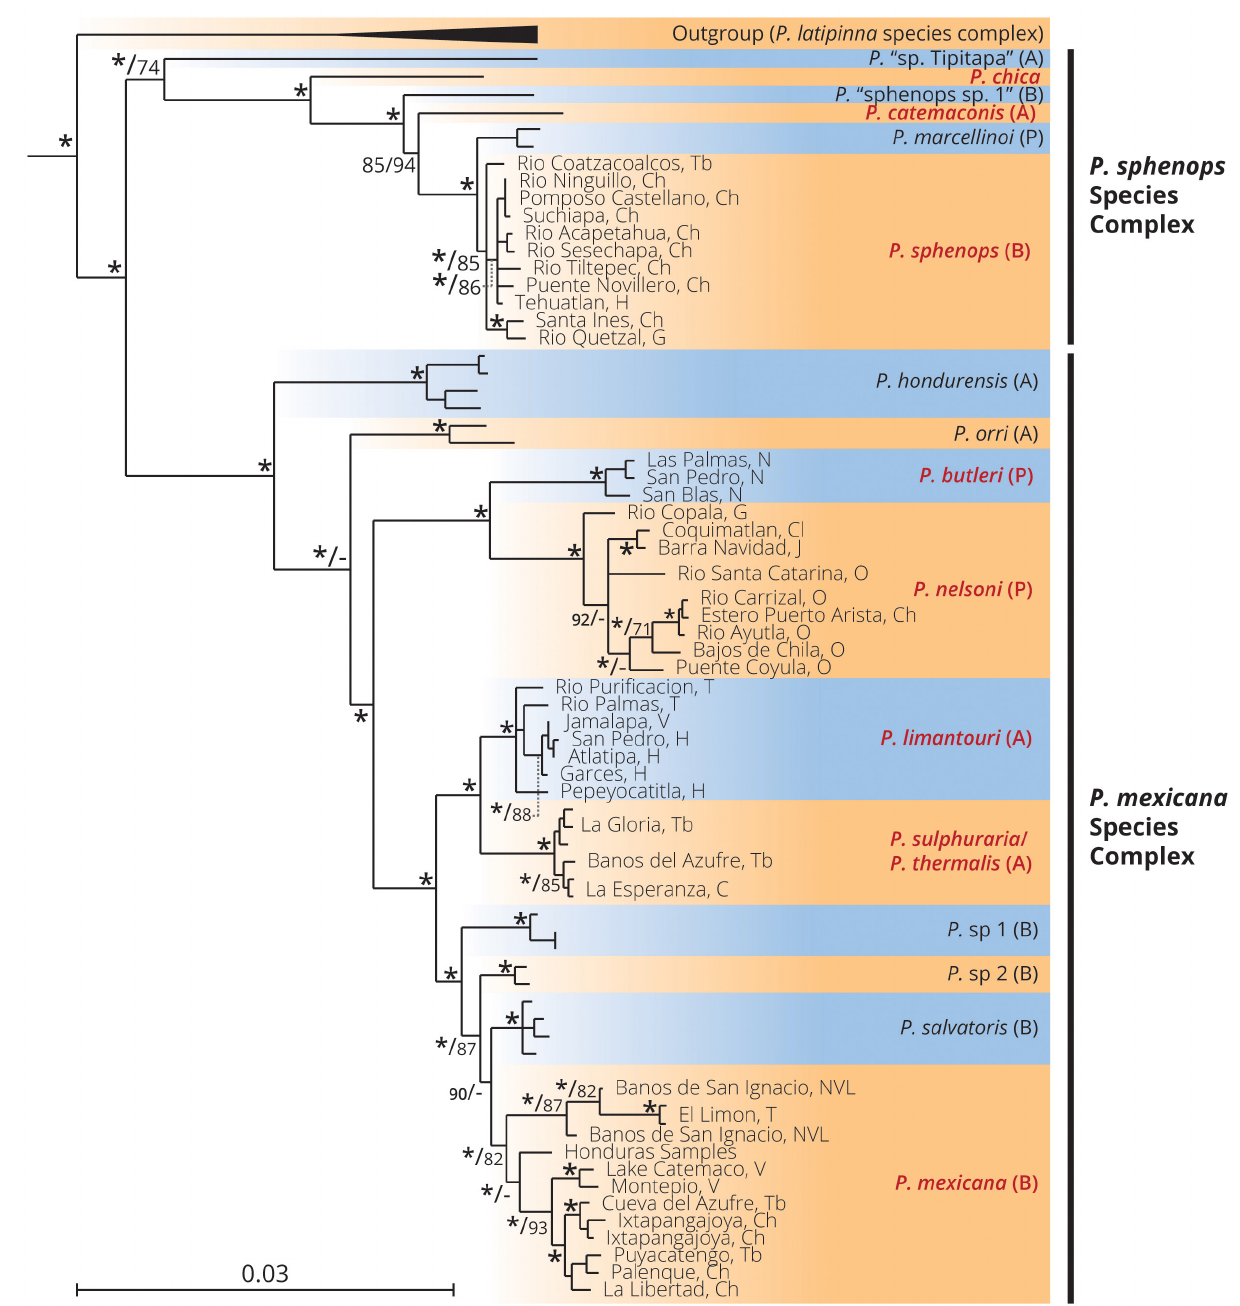
FIGURE 2 | Bayesian tree from the MrBayes partitioned analysis of Poecilia spp. for two mitochondrial genes (Cyt b and ND2, 2187 base pairs) and one nuclear (RAG1, 1561 base pairs) rooted with other poeciliid outgroups. Species names in black pertain to species outside of Mexico and species names in red are species found within Mexico. Species labels represent slope: (A) = Atlantic, (P) = Pacific, and (B) = Bi-coastal. Nodal support shown (left to right; respectively): Bayesian Posterior Probabilities followed by RAxML bootstrap support values. Asterisks denote nodal support of 95% or above for the two methods, and a single asterisk at a node indicates support values of 95% or above for both methods. Nodes with no values present either had low values or were of little interest for this study. The capital letters at the end of each sample represents the state of origin in Mexico, from North to South: T = Tamaulipas, NVL = Nuevo León, V = Veracruz, H = Hidalgo, M = Michoacan, G = Guerrero, O = Oaxaca, Tb = Tabasco, C =